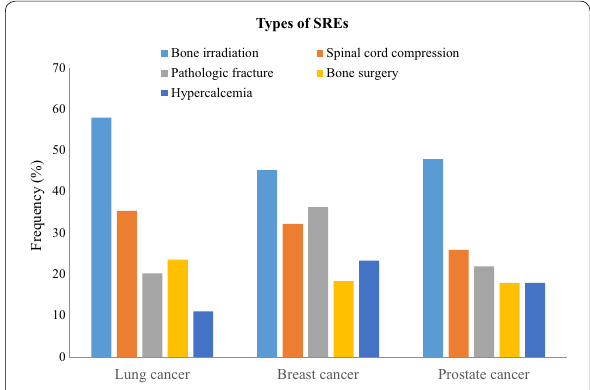
Fig. 1 Types of skeleton-related events (SREs) in patients with lung, breast, or prostate cancer. The frequency of bone irradiation was